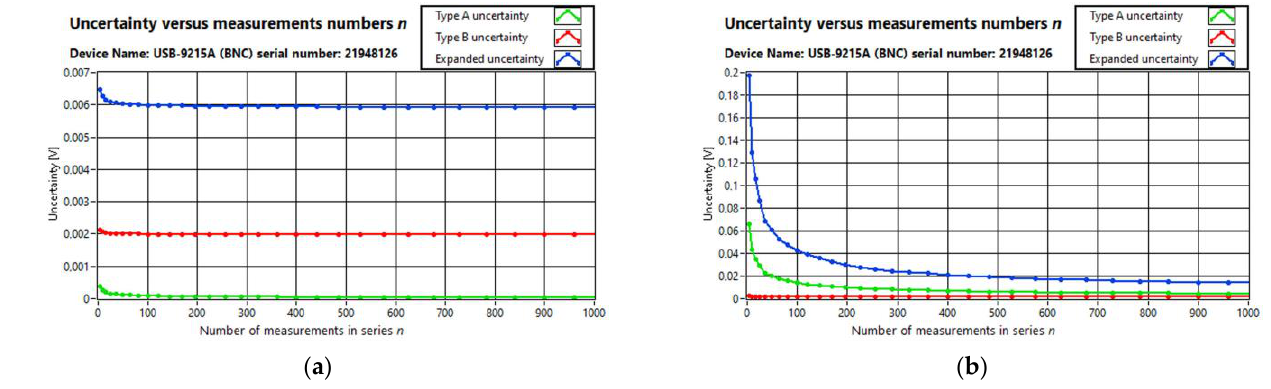
Figure 11. Uncertainties obtained from the measurements for the tested module NI USB-9215: ( a ) at low interference level, ( b ) at high interference level.